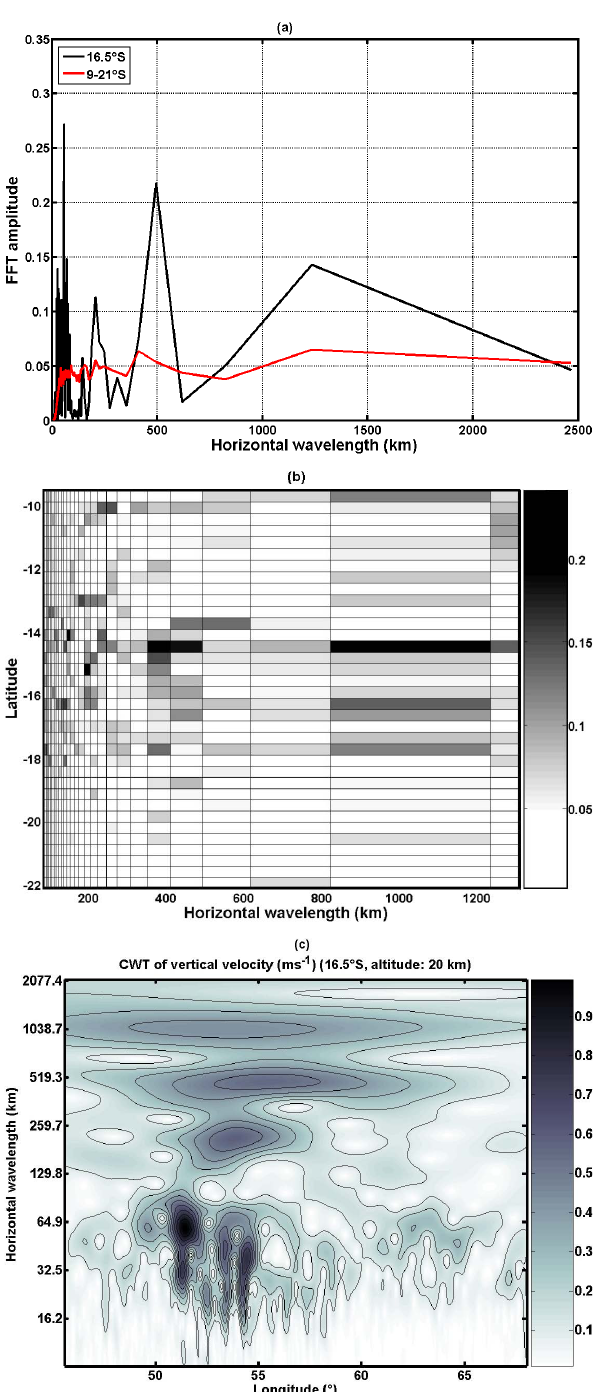
Fig. 12. Fast Fourier transform of vertical velocity (ms − 1 ) (a) at latitudes of 16.5 ◦ S and 9–21 ◦ S and (b) as a function of latitude at the altitude of 20km on 16 February 2008 at 12:00UTC. (c) Morlet continuous wavelet transform of vertical velocity at 16.5 ◦ S.